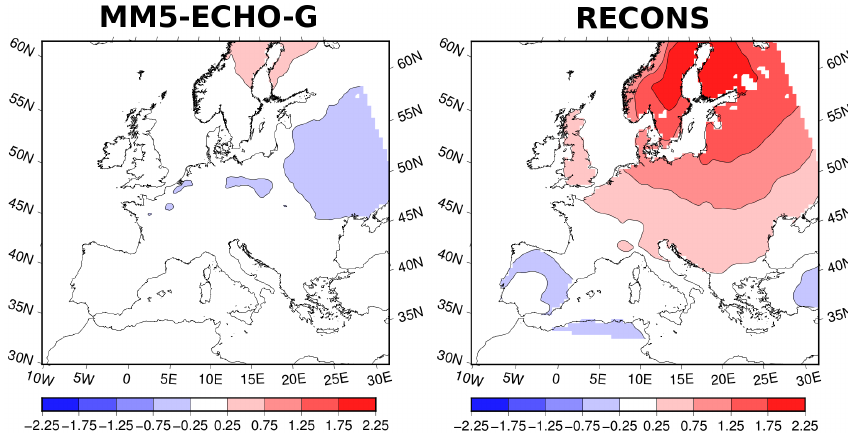
Figure 7. SAT anomalies in winter during the first decades of the 18th century (1700–1750) with respect to the previous century (1600–1700). Left and right maps show the results corresponding to the simulation and reconstruction,